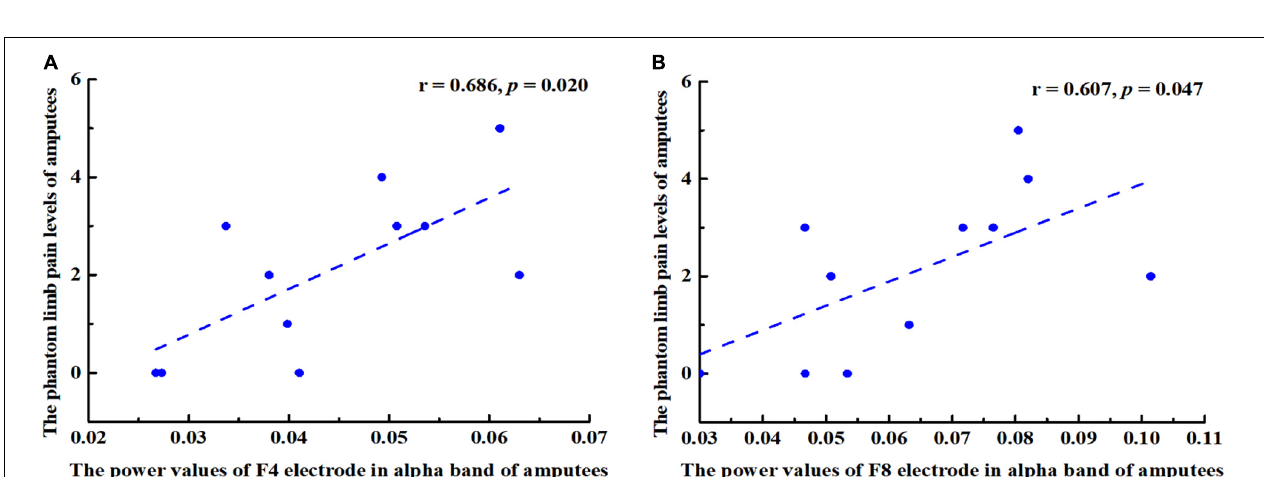
FIGURE 6 | Pearson correlation coefficient between changes in power values of alpha band (8–13 Hz) and the phantom limb pain (PLP) levels. (A) A positive correlation was found between F4 power values and PLP levels in amputees ( r = 0.686, p = 0.020. (B) F8 power values and PLP levels were positively correlated ( r = 0.607, p =